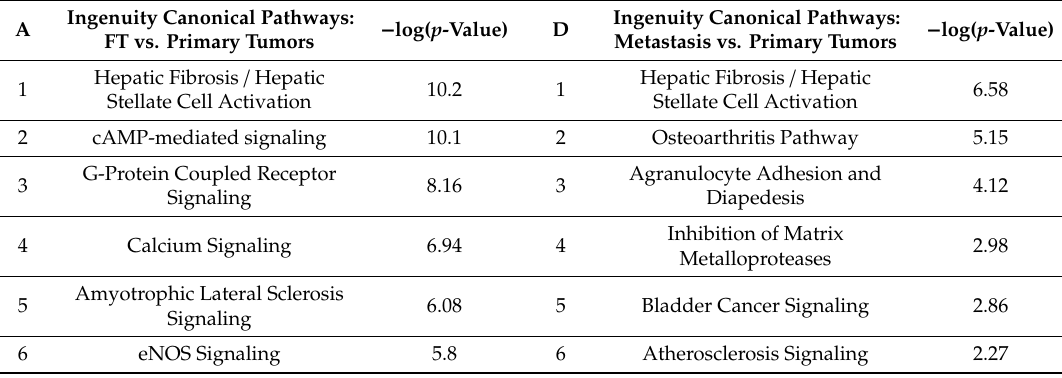
Table 1. Ingenuity pathway analysis (IPA) of di ff erentially regulated genes in ovarian cancer. (panel A ) Top 20 canonical pathways, (panel B ) Top disease functions and (panel C ) predicted upstream regulators in primary tumors versus FT. (panel D ) Top 20 canonical pathways, (panel E ) top disease functions and (panel F ) predicted upstream regulators in metastasis versus primary